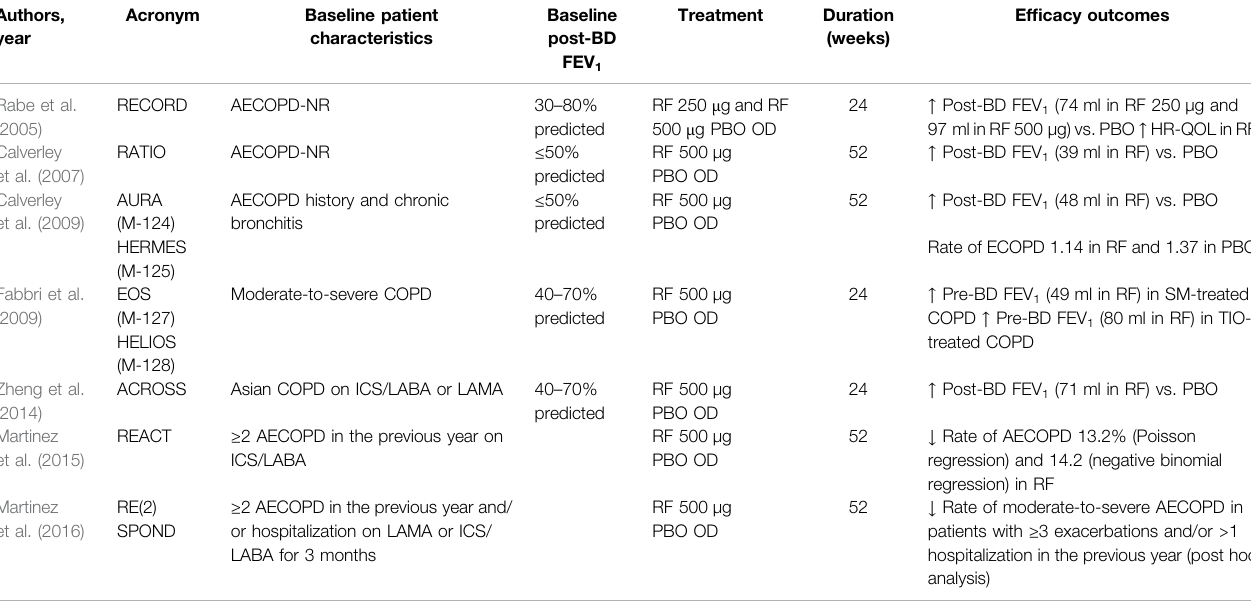
TABLE 1 | Summary of randomized clinical trials of ro fl umilast in COPD as COPD maintenance therapy. Authors,